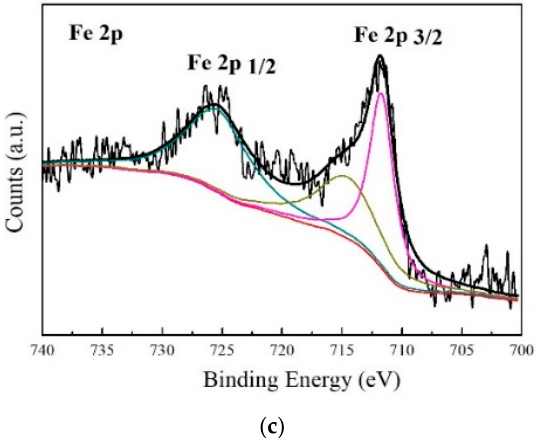
Figure 3. ( a ) Wide-scan XPS survey of BC, ( b ) wide-scan XPS survey of BC-nZVI, and ( c ) a high- resolution Fe 2p XPS survey of